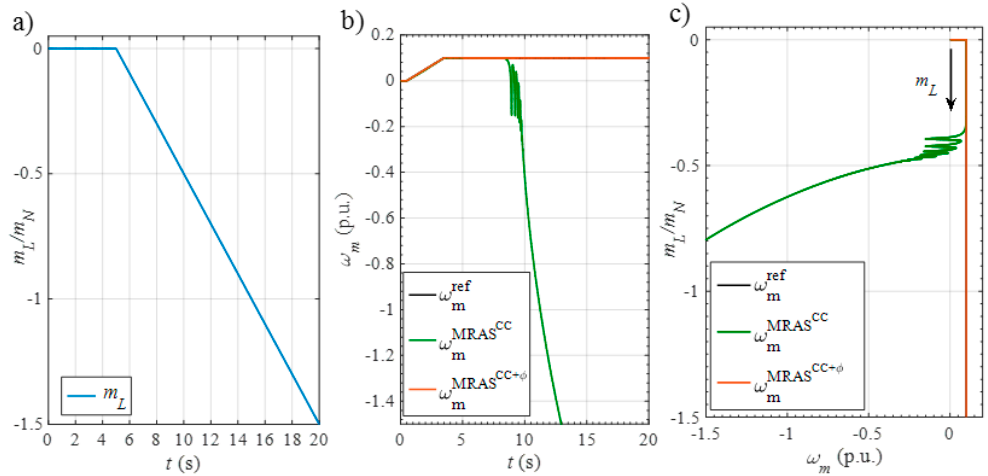
Figure 9. Illustration of the methodology for creating dynamic characteristics of the drive with a speed estimator: ( a ) load torque transient in regenerating mode, ( b ) set speed and estimated speed waveforms of two selected estimators MRAS CC and MRAS CC + ϕ , ( c ) the combination of ( a , b ) in form of mechanical